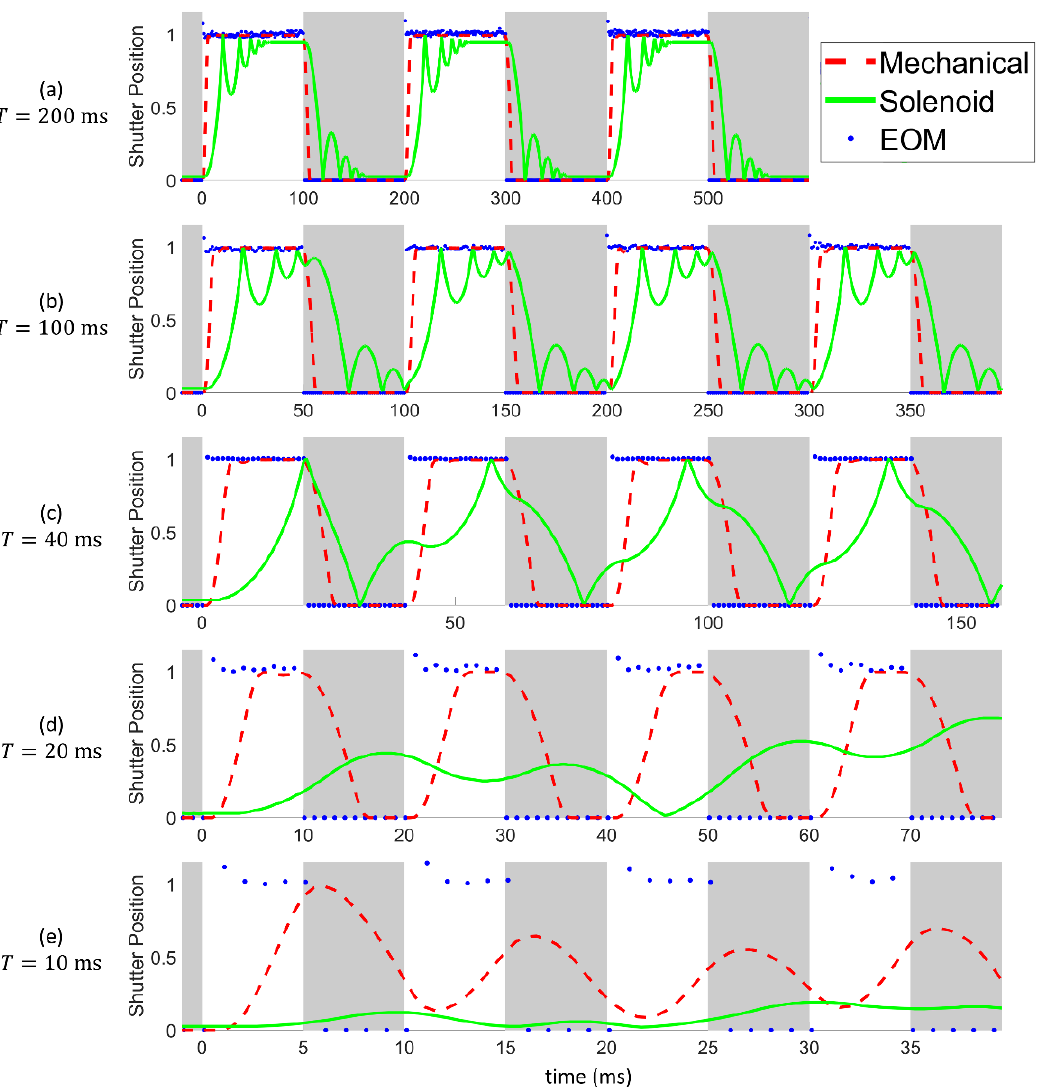
Figure 6. Measured position of each shutter over time for different cycling periods. ( a ) 𝑇 = 200